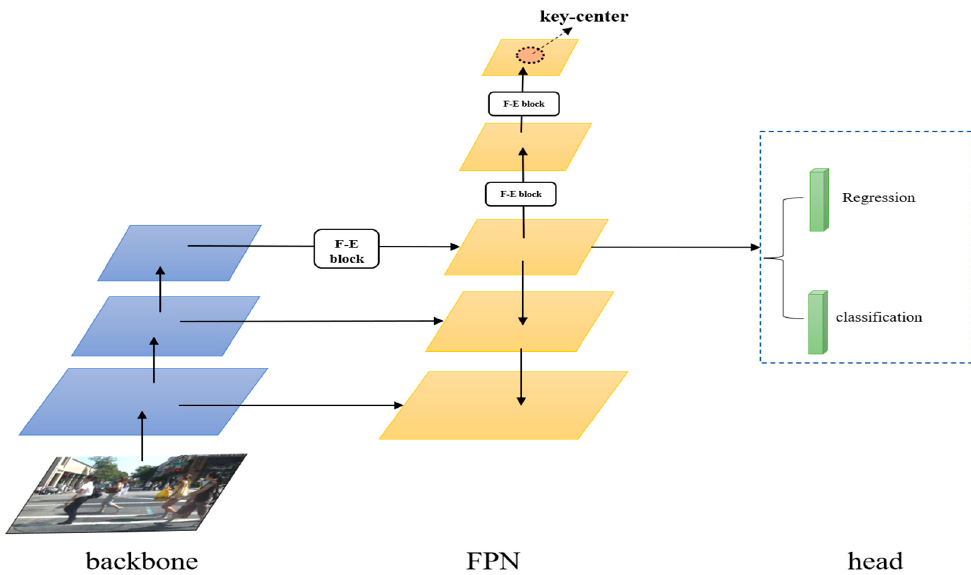
Figure 5. Structure of pedestrian detection model based on feature enhancement and multi-scale detection. The backbone is ResNet, while the feature network is a multi-scale feature pyramid network. The F-E block means feature-enhancement module, and the key-center region is also added to the feature network. The detection head is shared by different feature levels.